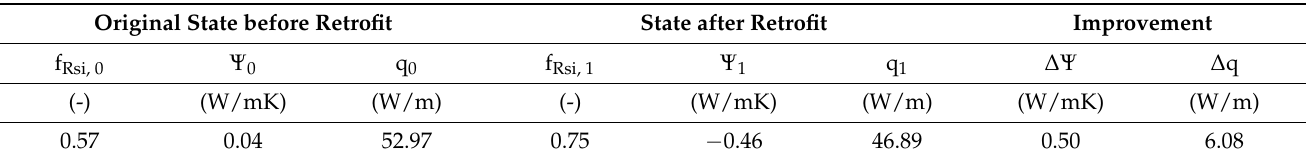
Table A5. Quantifiable results of the thermal bridge retrofit of a basement ceiling slab (ThermCad thermal bridge simula- tion